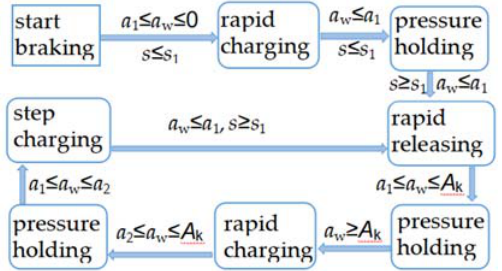
Figure 6. ABS logic threshold method control logic. s 1 -slip ratio threshold, a w -angular acceleration, a 1 -first threshold of angular acceleration, a 2 -second threshold of angular acceleration, A k -third threshold of angular acceleration.